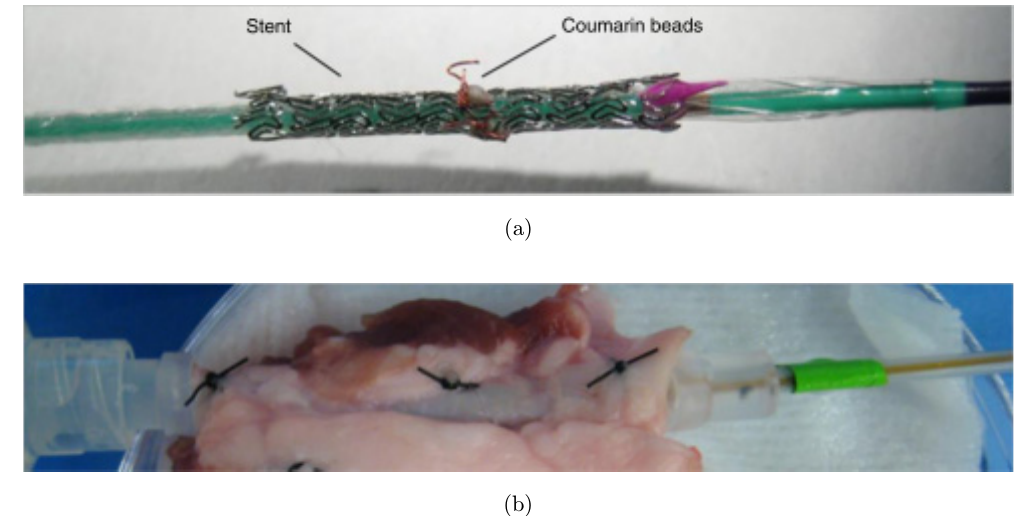
Fig. 13. IVUS-FLIM coregistration: evaluation of a coronary artery phantom. (a) Stent before deployment, (b) stent inserted in pig coronary artery; (c) open-loop intensity image; (d) folded open intensity lifetime image with intensity threshold; (e) IVUS image cross-section; and (f) reconstructed. 3D FLIM image of the coronary lumen. 50 (Permission has been granted by \SPIE".)